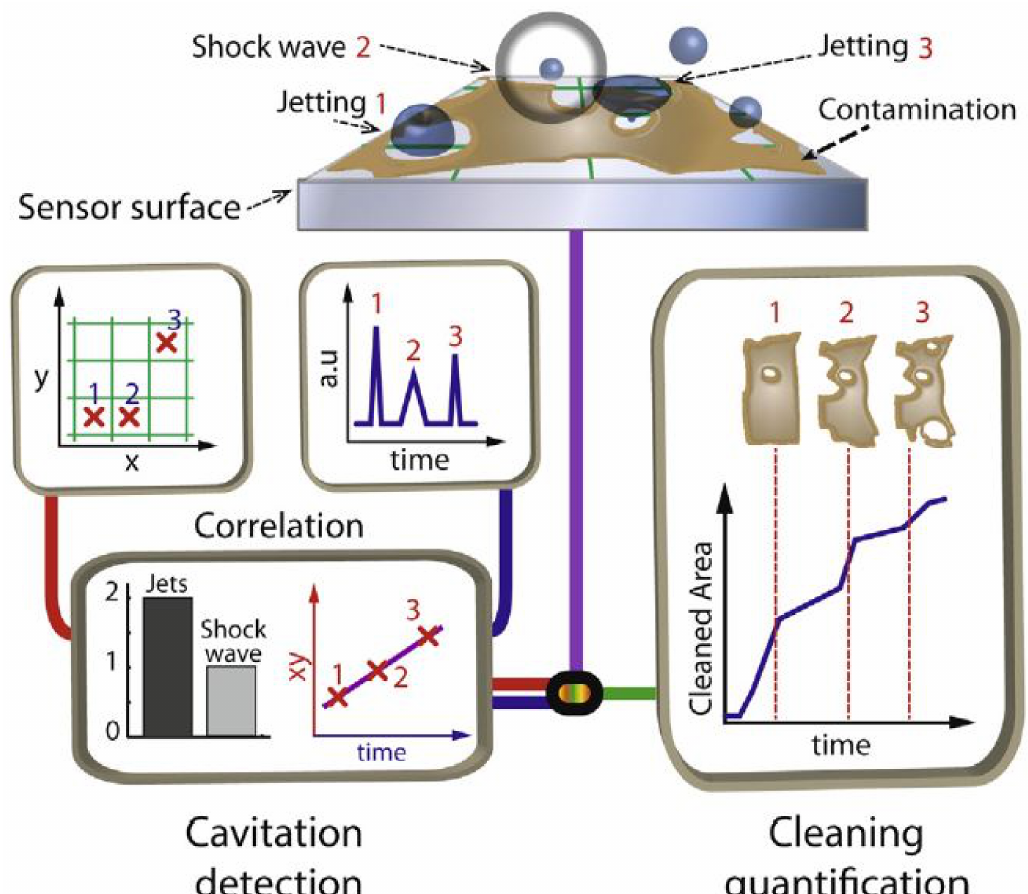
Figure 9. Identification of cavitation and amount of cleaning through ideal sensor